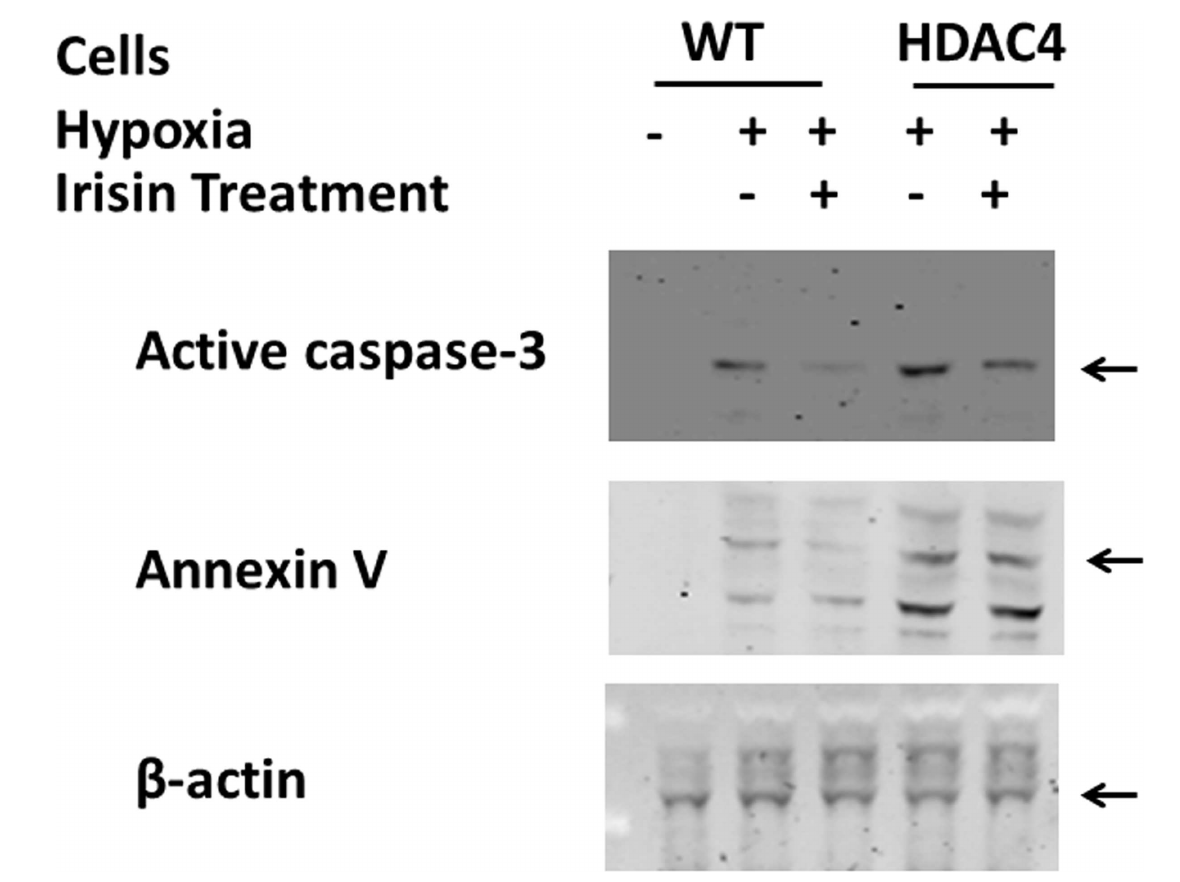
Fig 4. Irisin suppressed HDAC4 induced cell apoptosis after H/R. Active-caspase 3 and annexinV signals were significantly reducedby irisin treatment. Irisin mitigatedthe increasein both active caspase 3 and annexinV in HDAC4 overexpression